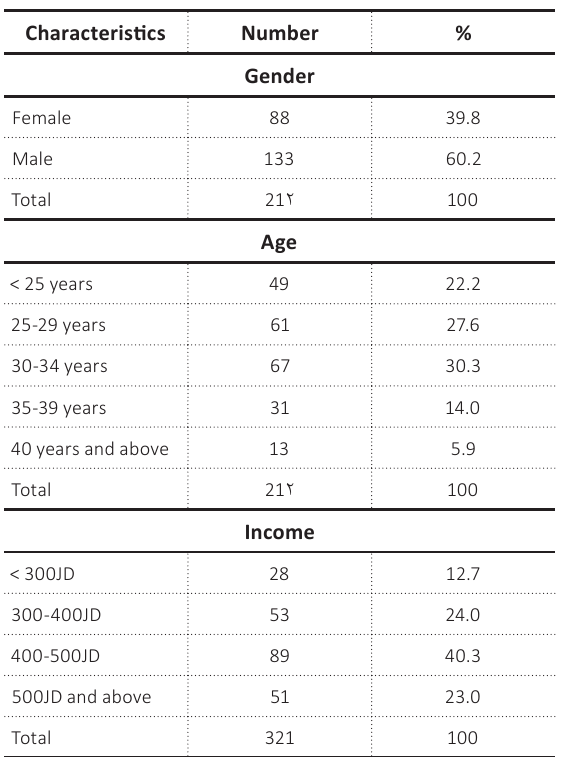
Table 1. Demographic characteristics